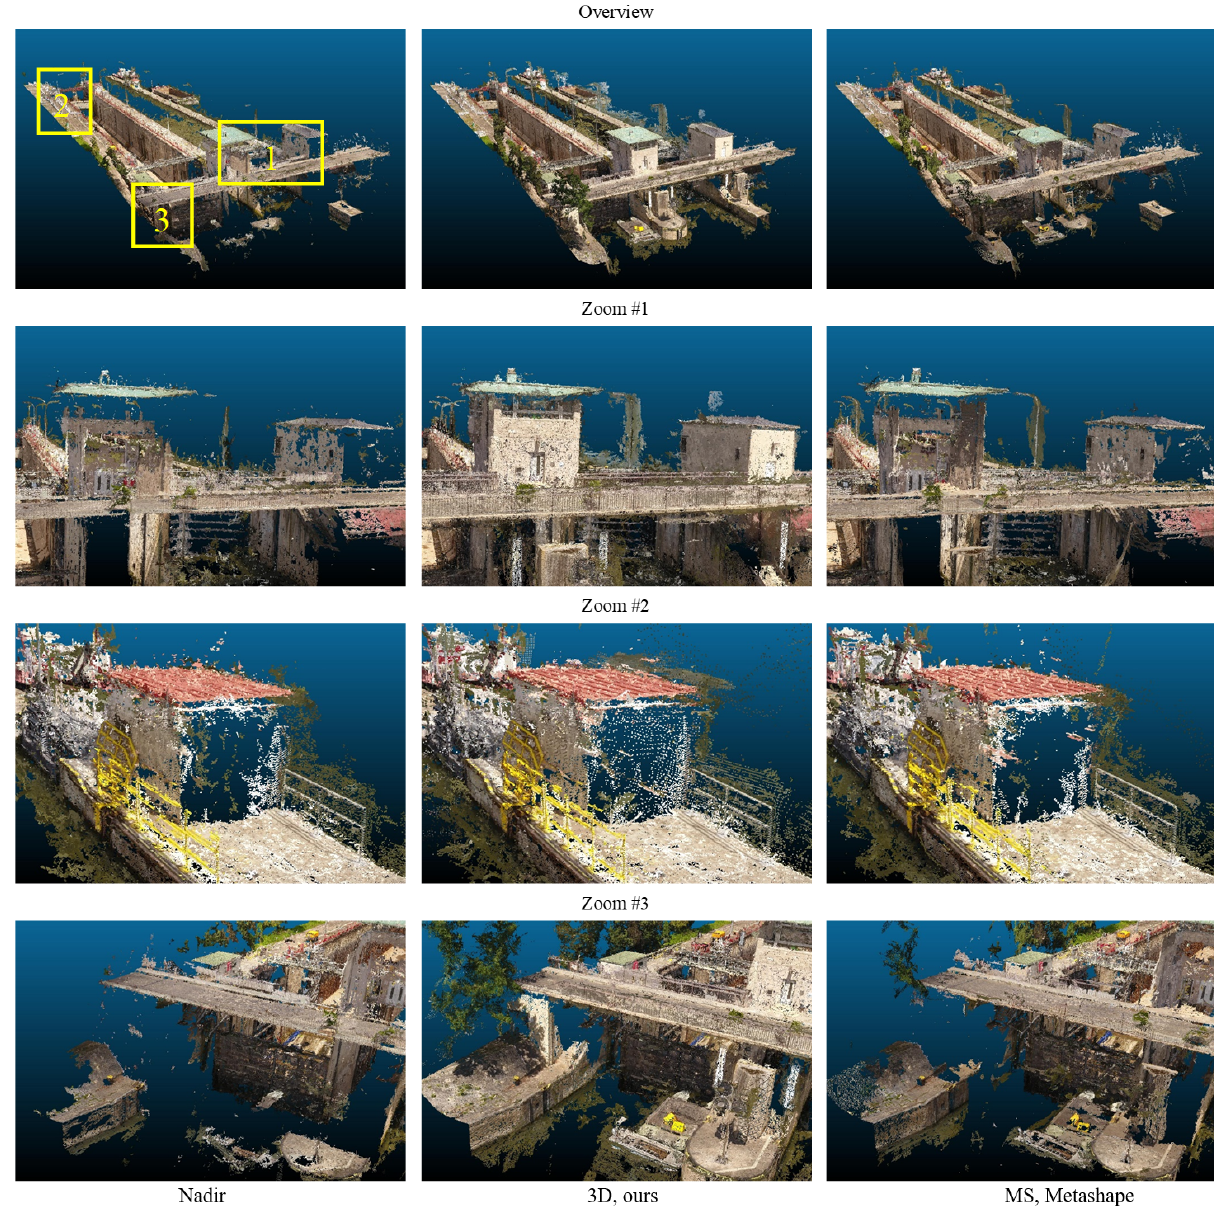
Figure 8. Overview and detailed comparison of DIM point cloud from different